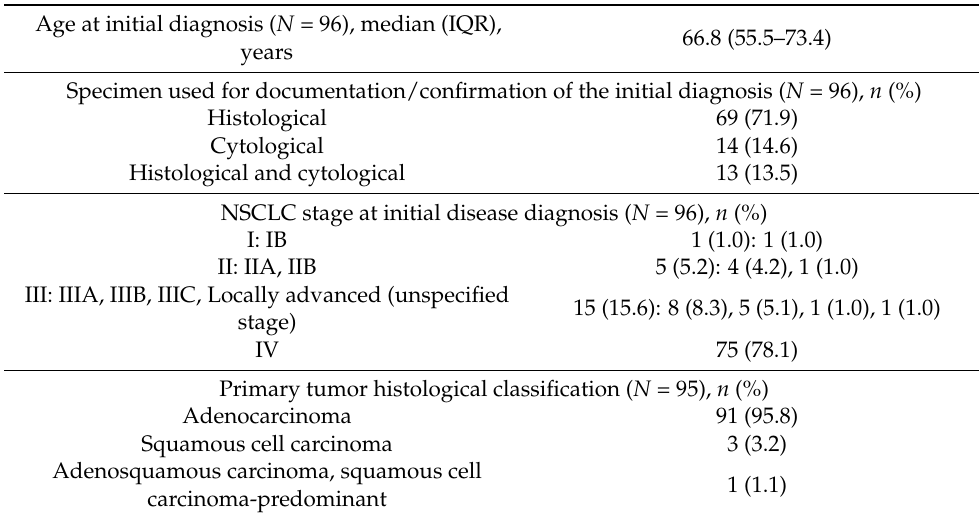
Table 2. NSCLC characteristics at initial and index NSCLC diagnosis and at initiation of EGFR-TKI in the first-line